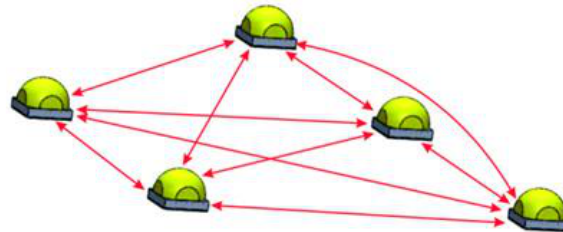
Figure 2. Thermal mutual coupling between LEDs.